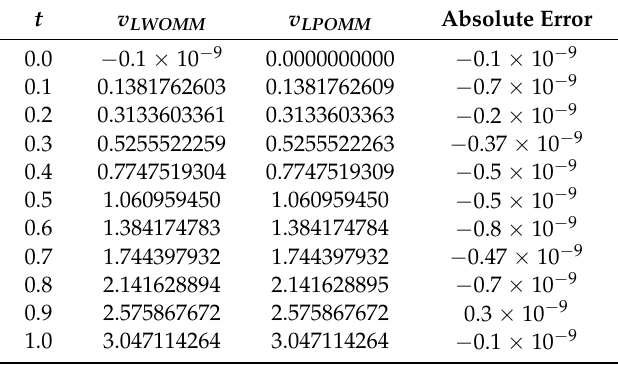
α= for Example Figure 2. Comparison of our solutions to the exact solution when 0.9, 0.7, 0.5 Figure 2. Comparison of our solutions to the exact solution when α = 0.9,0.7,0.5 for Example 3: ( a ) Our solution u ( t ); and ( b ) Our solution v ( t ). 3: ( a ) Our solution u ( t ) ; and ( b ) Our solution v ( t ) . Table 6. Our solutions v ( t ) when α = 0.9 attained by the presented method and the LPOMM for α= Table 6. Our solutions v ( t ) when 0.9 attained by the presented method and the LPOMM for Example Example 3.